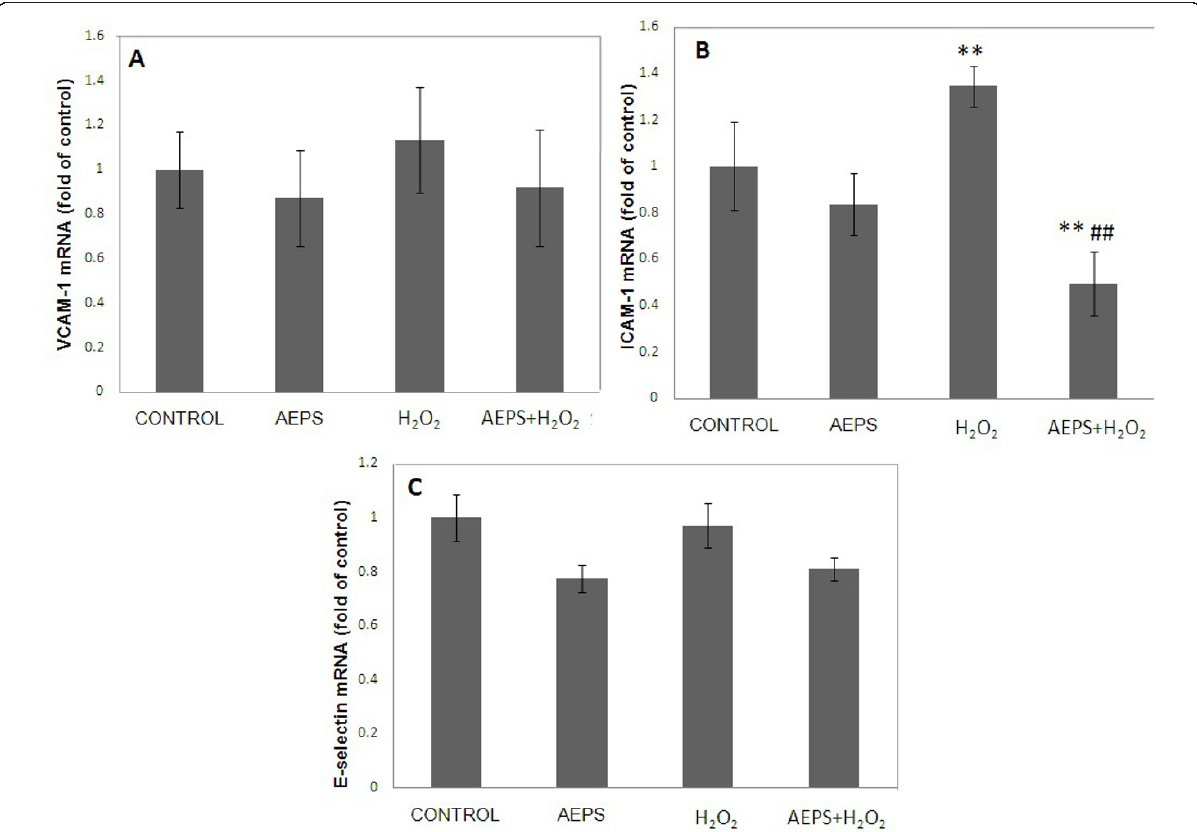
Figure 3 VCAM-1, ICAM-1 and E-selectin mRNA expression in HUVECs . Figure 3 represents the bar chart showing VCAM-1 (A), ICAM-1 (B) and E-selectin (C) mRNA expression in control, AEPS, H 2 O 2 and AEPS + H 2 O 2 groups. HUVECs treated with H 2 O 2 showed a significantly higher